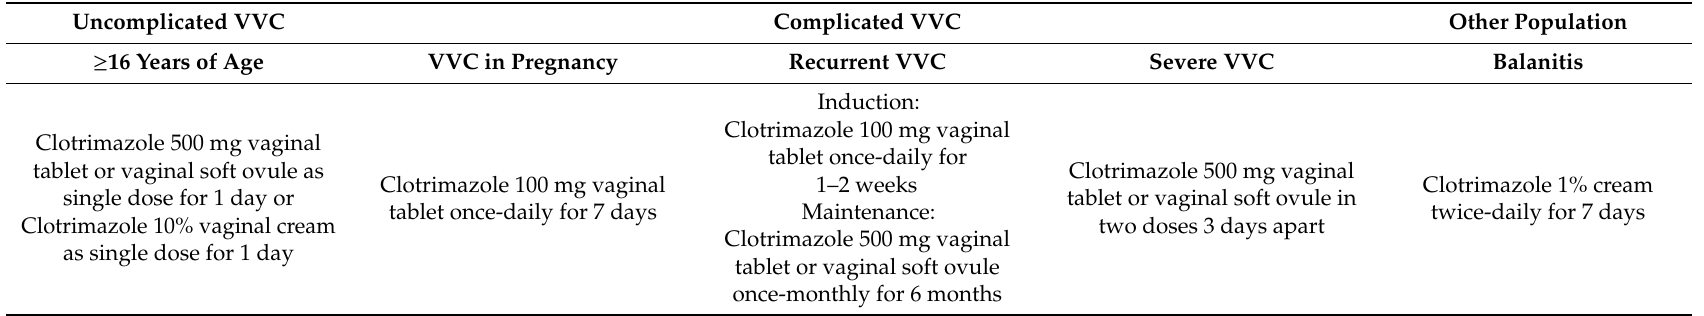
Table 5. Overview of suggested clotrimazole treatment